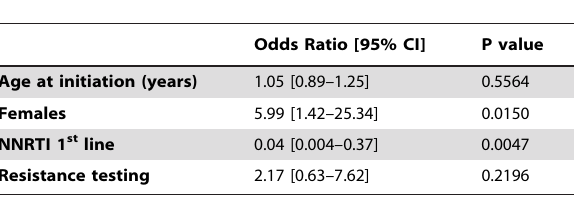
Table 3. Multivariate Analysis: Predictors of Six Month Viral Suppression After Change to Second-Line ART in a Cohort